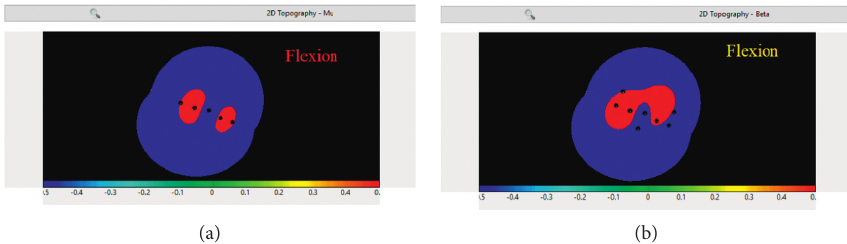
Figure 13: The ERD/ERS topographical view of the mu and beta frequencies during flexion activity.